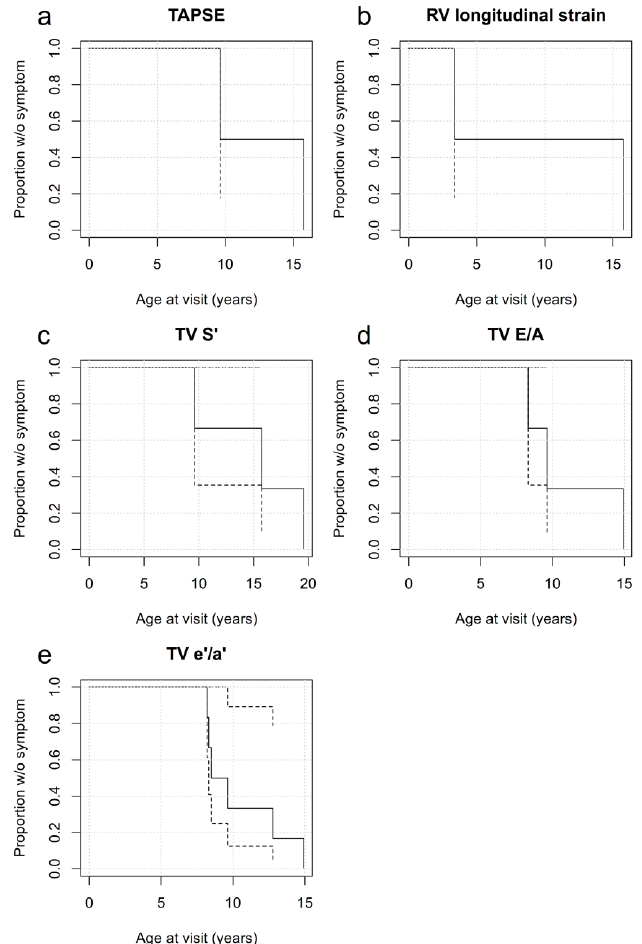
Figure 5. ( a ) – ( e ). Survival curves of proportions of patients without specific pathological RV func- tional parameters. With age, the probability of developing abnormal RV function increases according to age-dependent normative data. The dotted line indicates the 95% confidence interval. 3.4. Effect of Left Ventricular Size and Function on Right Ventricular Function N = 3 individuals (ID 4, 13, 14) had a DCM with a LVEDD above the normal range and abnormal parameters for LV-FS, LV-EF, LV-MPI, and LV-GLS. Of these, n = 1 (ID 4) had additional abnormal RV-longitudinal strain, and another one (ID 14) had abnormal values for TAPSE, TV S’ , and TV E/e’. The last one (ID 13) had no abnormal RV functional parameters. N = 1 individual (ID 9) had a dilated LV without pathological LV functional parameters; this patient also had normal values for all RV functional parameters. Regarding the correlation of RV and LV function, there is a significant correlation between TAPSE and MAPSE, and RV longitudinal strain and LV-GLS ( p ≤ 0.05). Correla- tion was more significant between LV functional parameters: LV-EF and LV-FS ( p ≤ 0.001), LV-EF and LV-MPI ( p ≤ 0.05), LV-FS and LV-MPI ( p ≤ 0.01), LV-FS and MAPSE ( p ≤ 0.01),